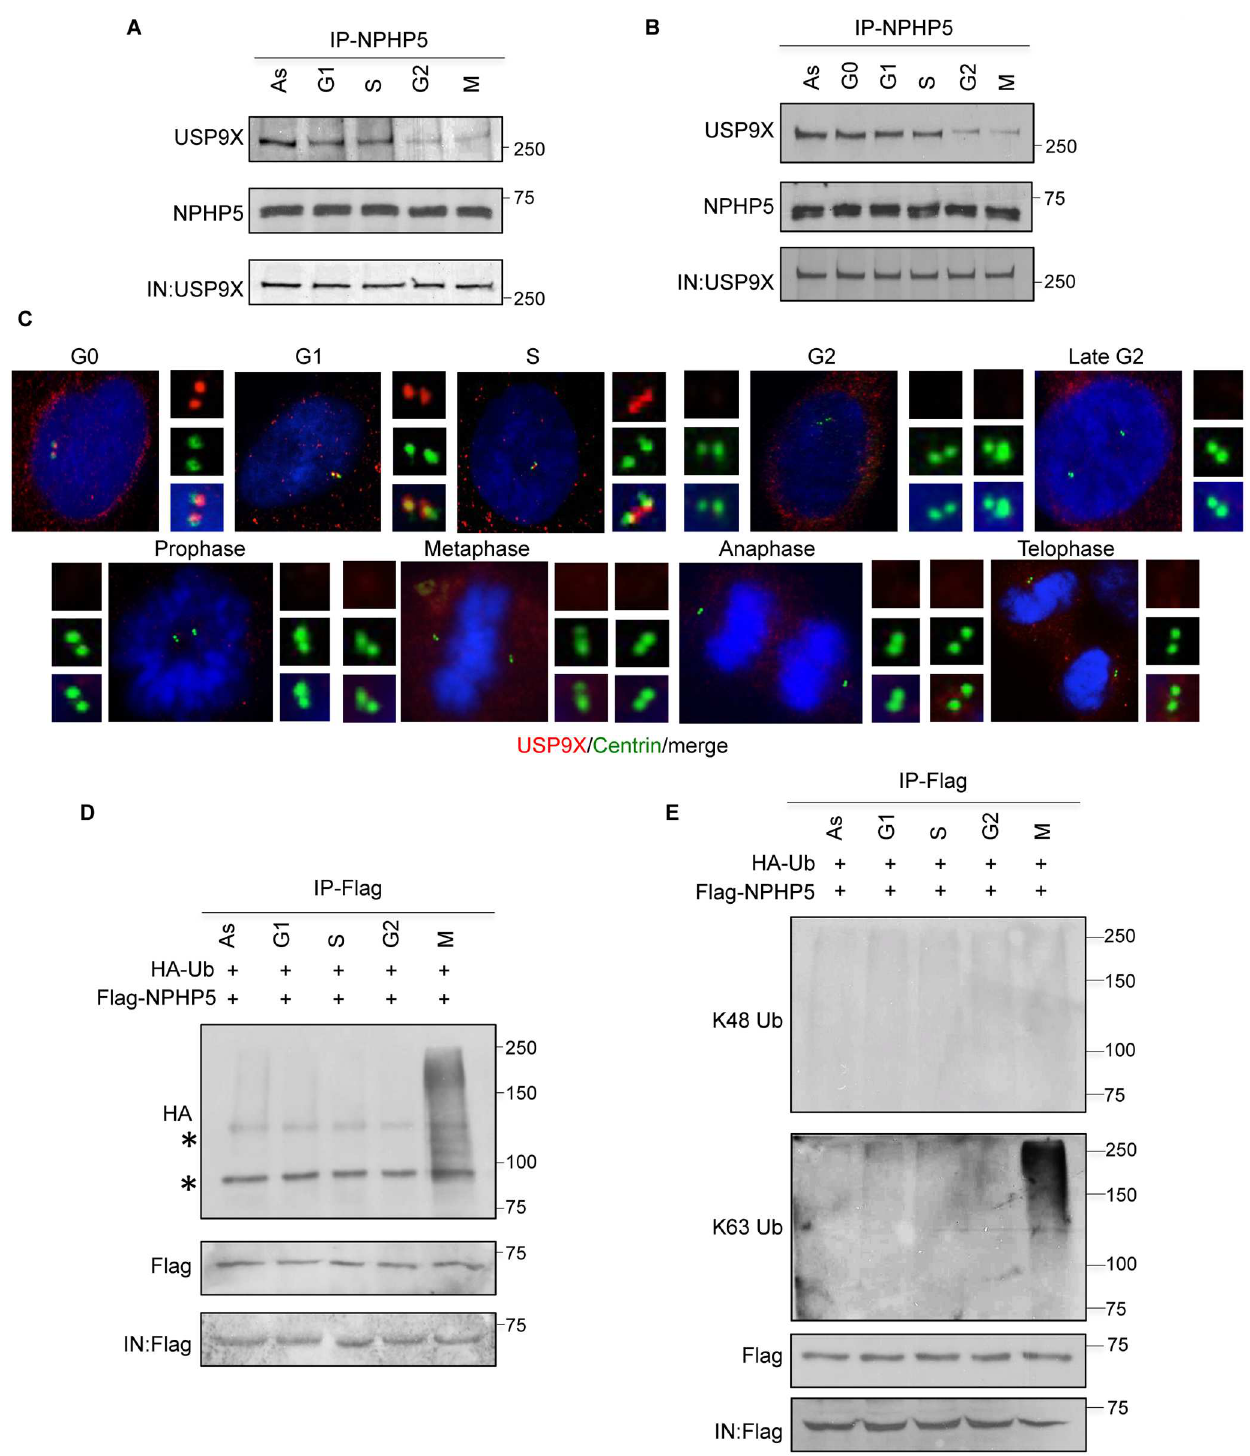
Fig 6. NPHP5 is a low turnover protein which becomes K63 ubiquitinated in mitosis. A-B) U2OS A) and RPE-1 B) lysates from different cell cycle phases were immunoprecipitatedwith anti-NPHP5 (IRCM1) antibody and Western blotted with the indicatedantibodies. As, asynchronous; IN, input. C) RPE-1 cells in different stages of the cell cycle were processedfor immunofluorescencewith anti-USP9X(red) and anti-centrin (green)antibodies. DNA was stained with DAPI (blue). D-E) U2OS cells expressingFlag-NPHP5 and HA-Ub were synchronized in different cell cycle phases or left asynchronized (As). Lysates were immunoprecipitatedwith anti-Flag antibody in 1% SDS and Western blotted with the indicatedantibodies.IN, input. Asterisks indicate non-specific bands. https://doi.org/10.1371/journal.pgen.1006791.g006 PLOS Genetics | https://doi.org/10.1371/journal.pgen.1006791 May 12,